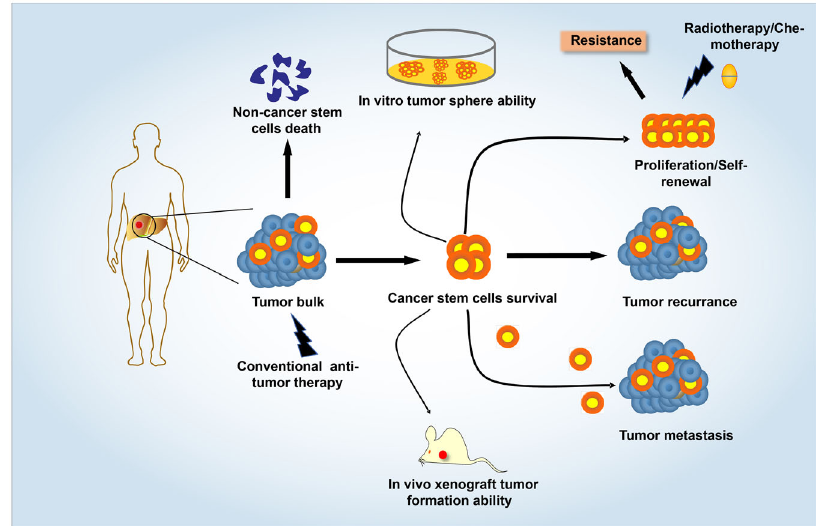
Fig. 1 The characteristics of cancer stem cells. Due to the resistance of CSCs to conventional treatment, the majority of tumor patients have recurrent and metastatic disease after receiving conventional antitumor therapy. In vitro, a single CSC possesses the capability to form tumor spheroids, which represent the self-renew and proliferation ability of CSCs. In vivo, a small number of cancer stem-like cells can trigger tumor forming in mice. In addition, CSCs have inherent drug resistance and dormancy characteristics, as well as the ability to trigger distant metastasis of